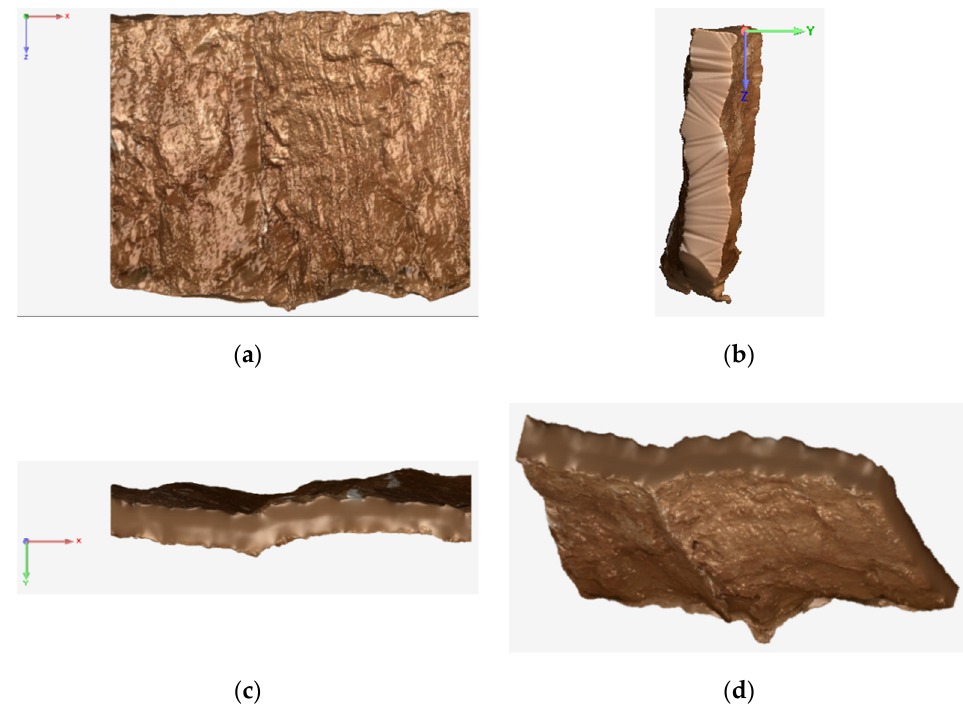
Figure 8. 3D modeling of the ground fissure: ( a ) Front view of the ground fissure; ( b ) Left view of the ground fissure; ( c ) Top view of the ground fissure; ( d ) 45-degree side view of the ground fissure.